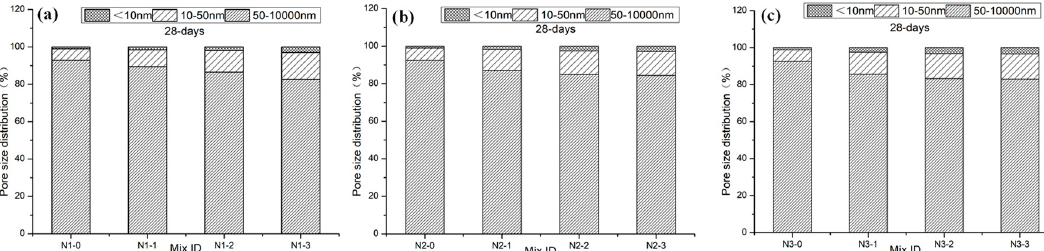
Figure 11. Percent of macropores, mesopores, and nanopores of the samples after modification: ( a ) Group N1, ( b ) group N2, and ( c ) group N3. Table 3. Effect of LS on porosity of NHL-based mortar cured for 28-days (wt %). Concentration of LS Group N1 Group N2 Group N3